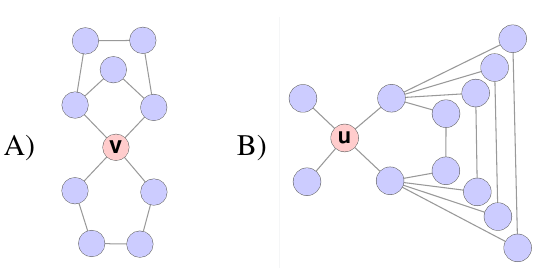
Figure 1: Cycle coefficient computation example.